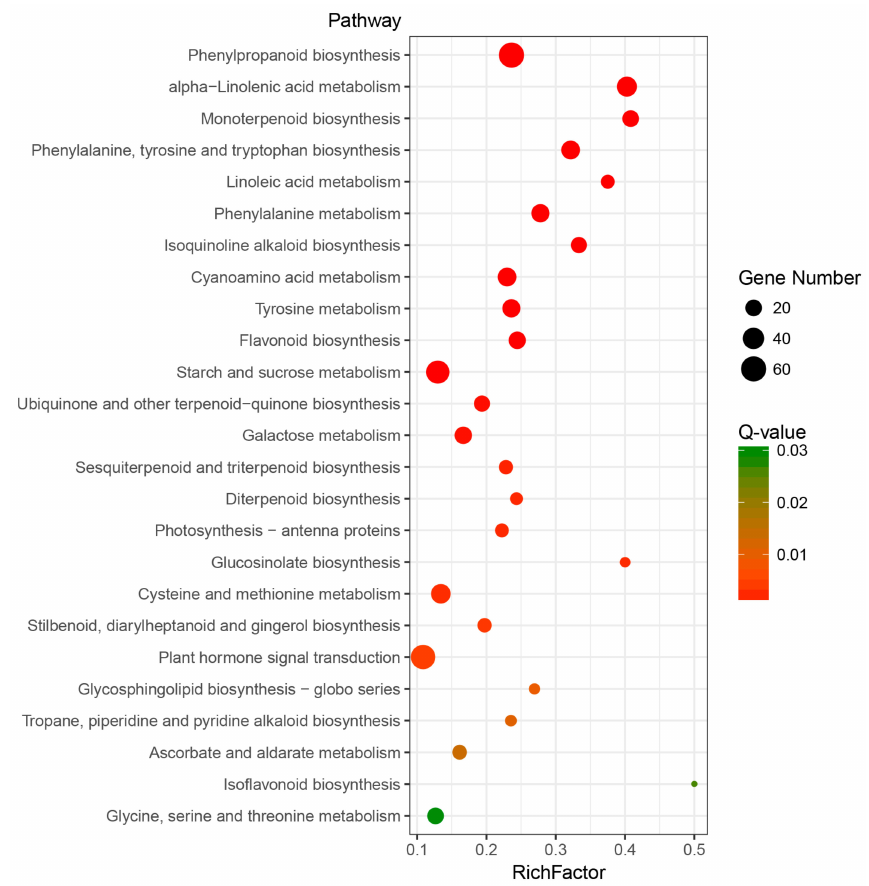
Figure 2. KEGG pathway enrichment of DEGs induced by